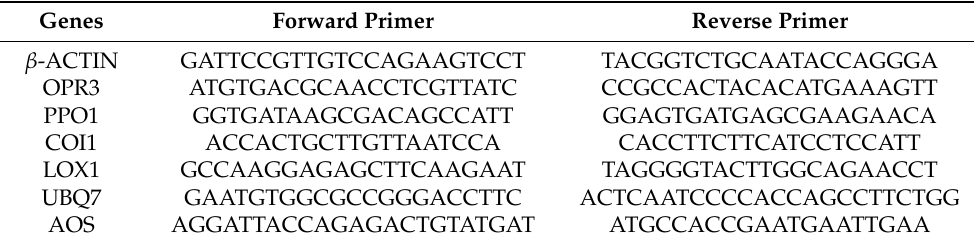
Table 1. Sequences of primer pairs used for RT-qPCR amplifications of major genes possibly impli- cated in JA- and SA-associated plant defense